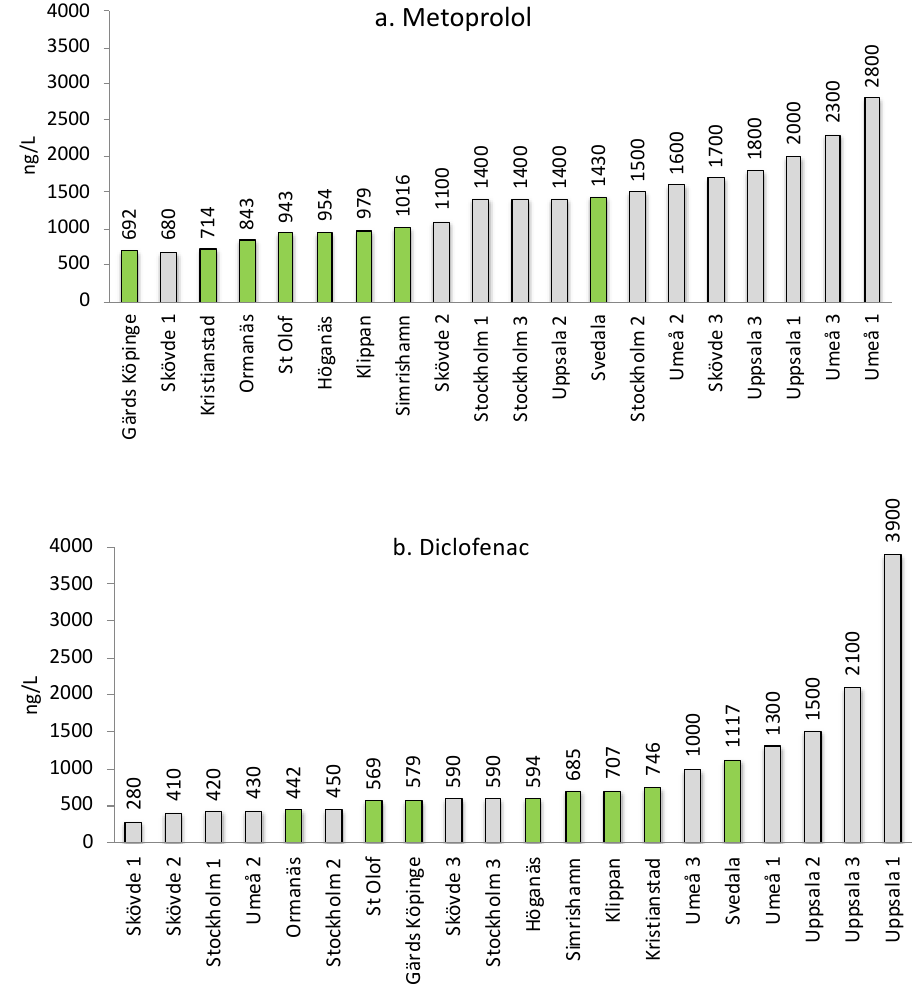
Figure 4. Measured concentrations (ng/L) of ( a ) metoprolol and ( b ) diclofenac in outlet water from the 8 Scanian WWTPs and in the Swedish National Screening Programme (Report 2011) for the cities Skövde, Stockholm, Uppsala and Umeå. The WWTPs in these 4 cities were analyzed three times each, as indicated by 1, 2 and 3. The 8 Scanian WWTPs are shown in green bars. The concentrations in the Scanian WWTPs are on a par or somewhat below the results from the National Screening. It should be noted that no Scanian WWTPs were included in either Stockholm Vatten [24] or in National Screening [34], thus highlighting the need for a regional assessment of the pharmaceutical load in this highly populated Swedish area. Metoprolol was also recently identified at up to 10 ng/L in the large Swedish lake Mälaren, showing that this compound is present in the Swedish aquatic environment